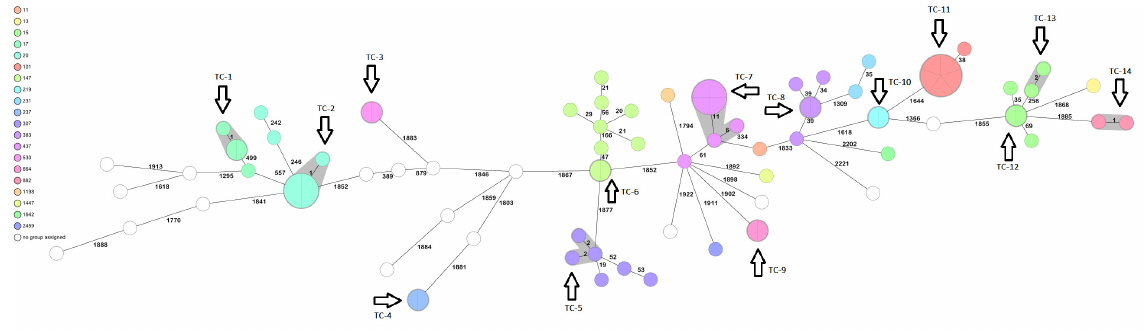
Figure 2. Ridom SeqSphere+ minimum spanning tree (MST) for 84 samples based on 2358 columns, pairwise ignoring missing values, logarithmic scale, K. pneumoniae MLST Pasteur (7). Cluster distance threshold: 15. Isolates are grouped by colour, indicating the different STs. Thirty-seven different STs were identified, in addition to 14 transmission clusters, represented by shaded nodes and